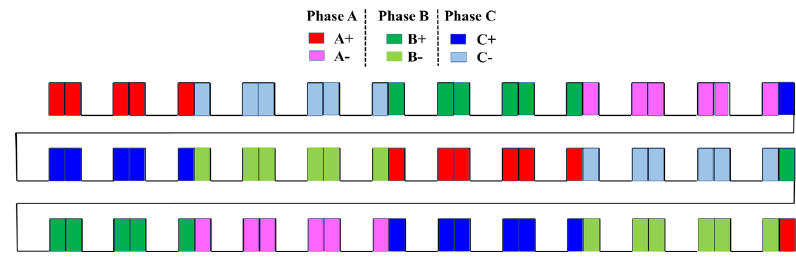
Figure 2. Armature and rotor windings configuration.